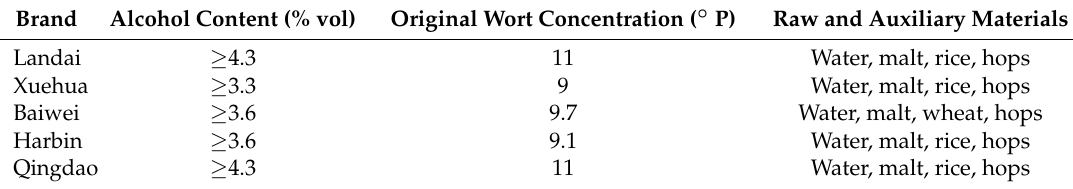
Table 1. Characteristics of sampled beers.